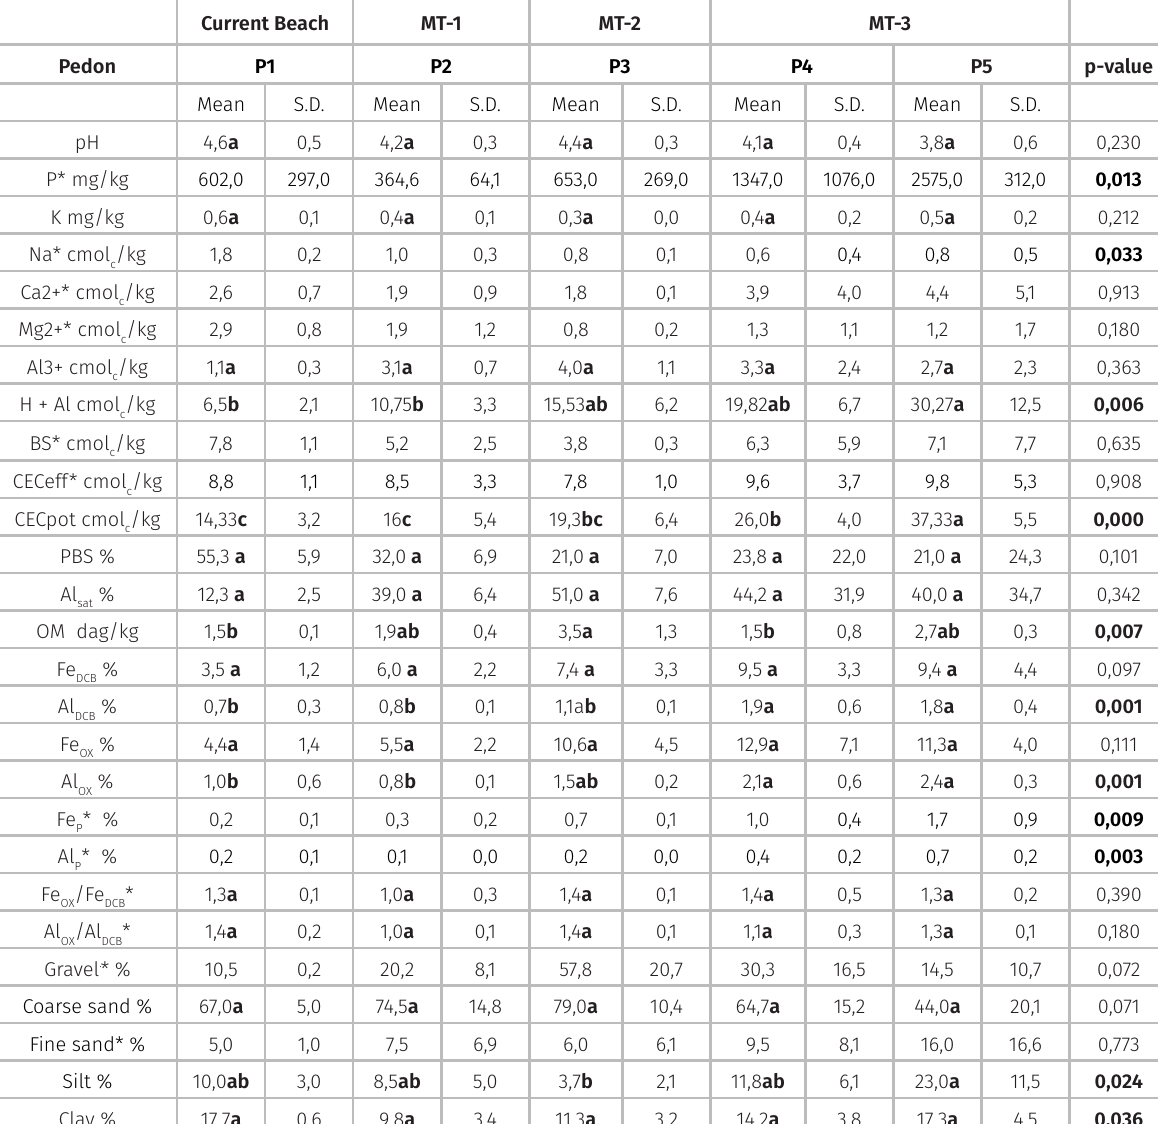
Table IV. Summary statistics of soil properties for pedons from HP marine terraces. Current